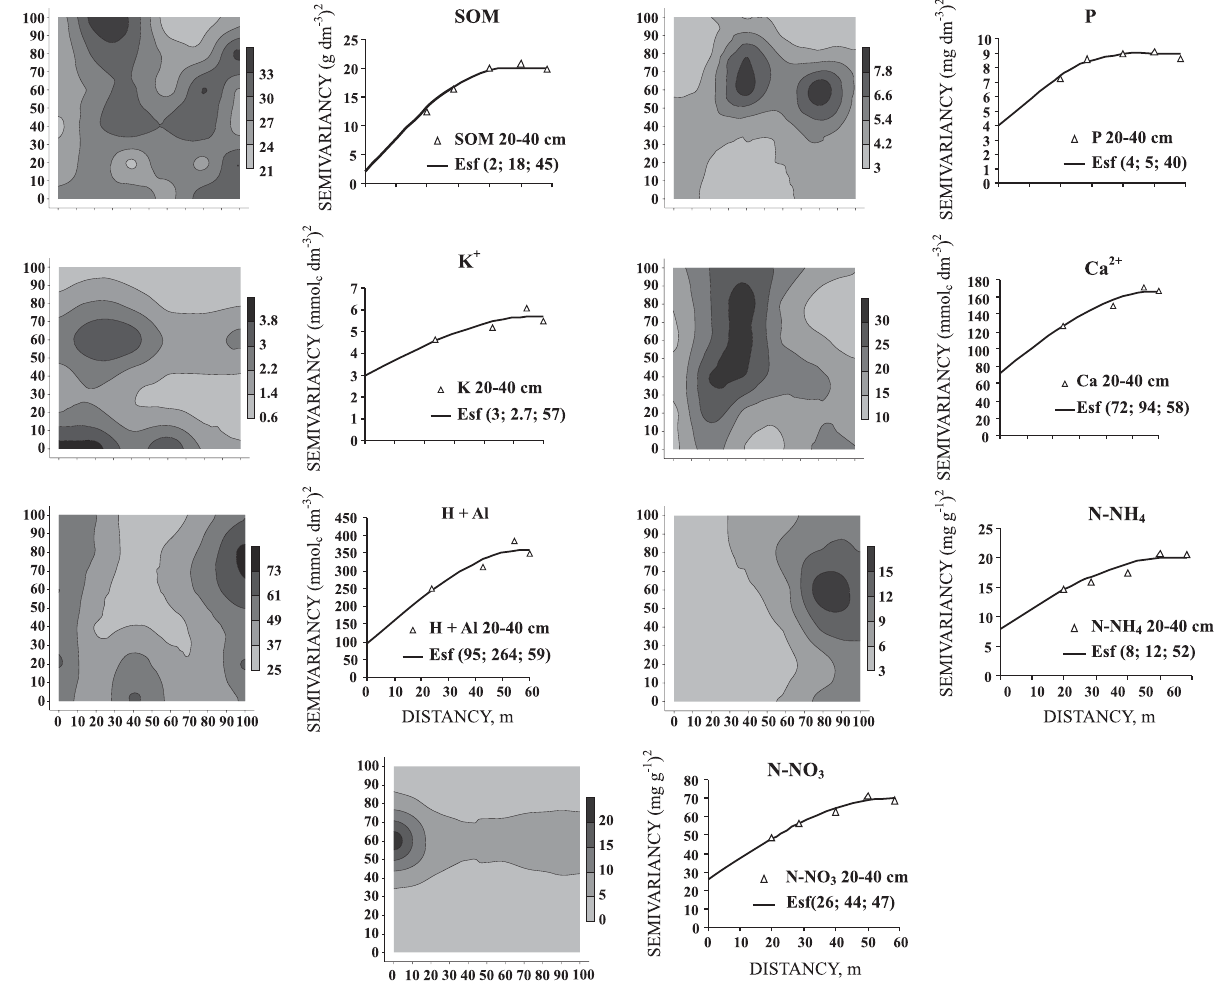
Figure 5. Spatial variability maps of soil properties in the 0.2–0.4 m layer. Model (C